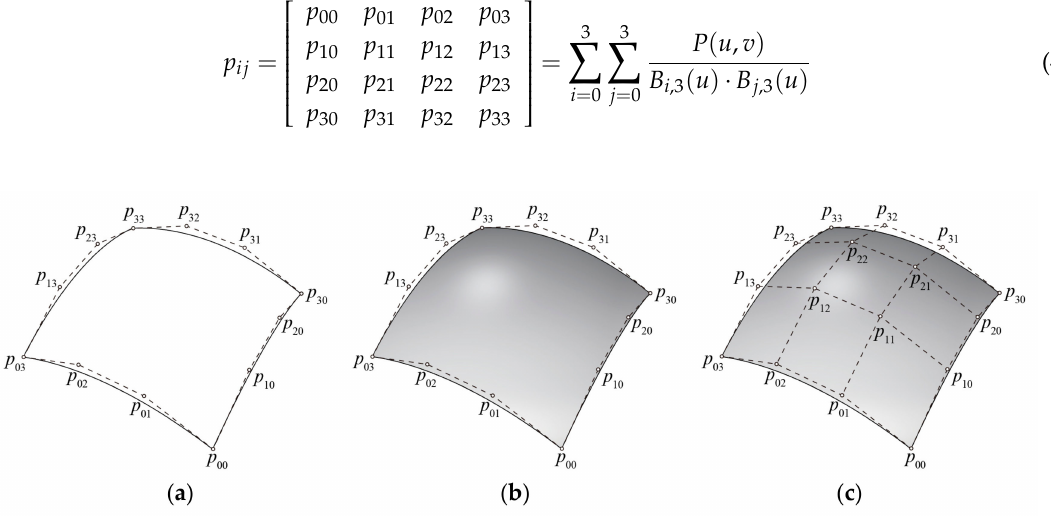
Figure 1. The approaches to obtain four virtual control points besides the boundary control points by transforming the Coons surface into the B é zier surface: ( a ) Four boundary curves and 12 control points on the B é zier surface; ( b ) The Coons surface generated accroading to the boundary curves; ( c ) 16 control points of the B é zier surface converted from the Coons